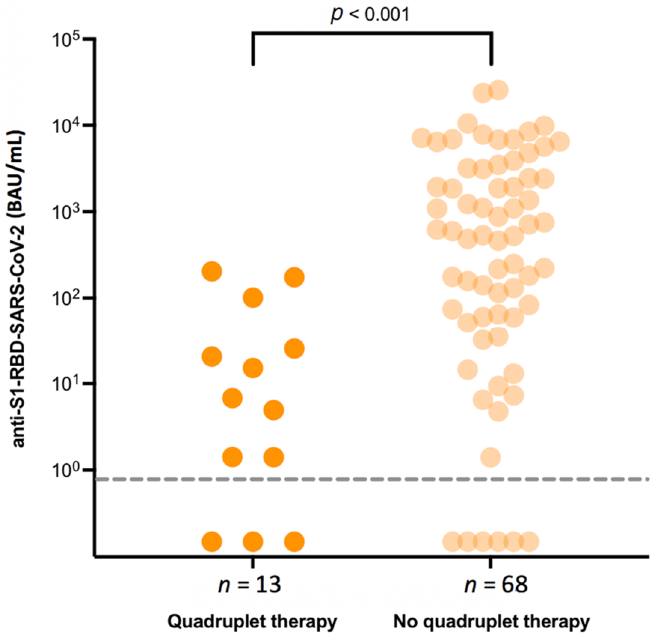
Figure 2. Serological response depending on concomitant quadruplet treatment. Table 2. Multiple linear regression of factors associated with logarithmized antibody titers in myeloma